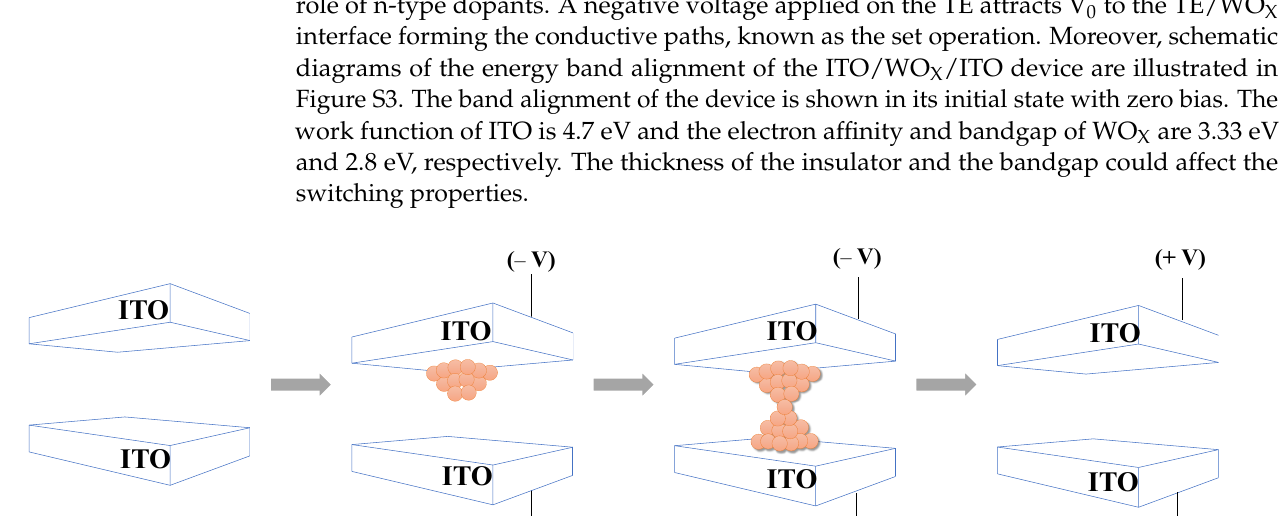
Figure 3. Electrical characteristics of ITO/WO X /ITO device. ( a ) First voltage sweep determining the type of I – V curve according to the reset process. ( b ) Gradual analog switching achieved from the partial reset. ( c ) Retention, read at the voltage of 0.2 V at room temperature for over 10 4 s. ( d ) Endurance characteristics evaluated through DC voltage cycles.